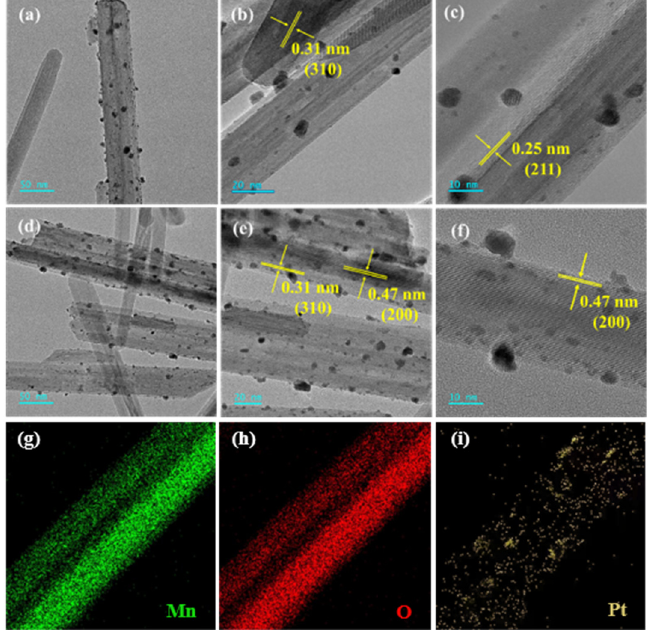
Figure 4. ( a – f ) TEM images of ( a – c ) 0.93Pt/ α -MnO 2 and ( d – f ) 0.94Pt-1.0rGO/ α -MnO 2 , and ( g – i ) ele- mental mappings of 0.94Pt-1.0rGO/ α -MnO 2 .